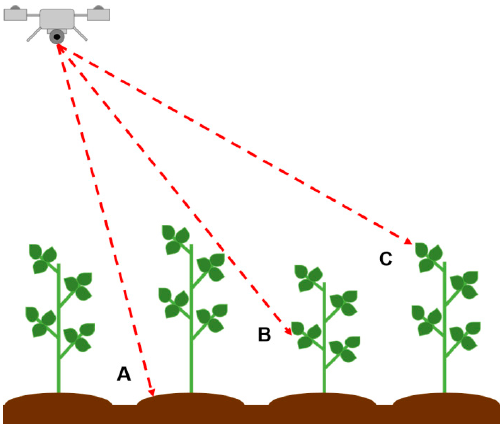
Figure 3. Representation of intermediate plant heights in low-altitude remote sensing (LARS)-derived point clouds. In this image, line-of-sight from the unmanned aerial system (UAS) is depicted for three angles, labeled A, B, and C. The UAS is able to detect the ground (A), the lower leaves of a plant (B), and the top of the plant (C) for the plant spacing shown in the figure. As the space between plants increases (e.g., due to increasing row spacing), the height of points detected at viewing angle (B) will become lower, and the “plants” distribution in a mixture will have a lower mean value, irrespective of actual plant height. This poses a problem for approaches that use one distributional characteristic (e.g., mean or maximum) for multiple plant spacing patterns or architecture. The problem is solved by fitting distributions to latent classes of data and choosing, empirically or analytically, the optimal parameter or quantile for a given application.